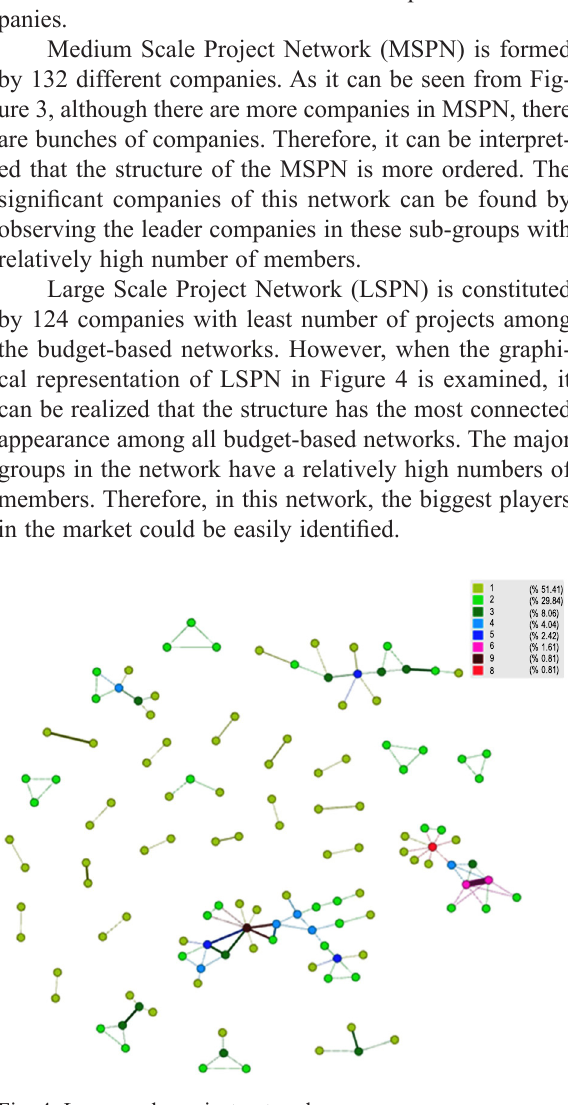
Fig. 4. Large scale project